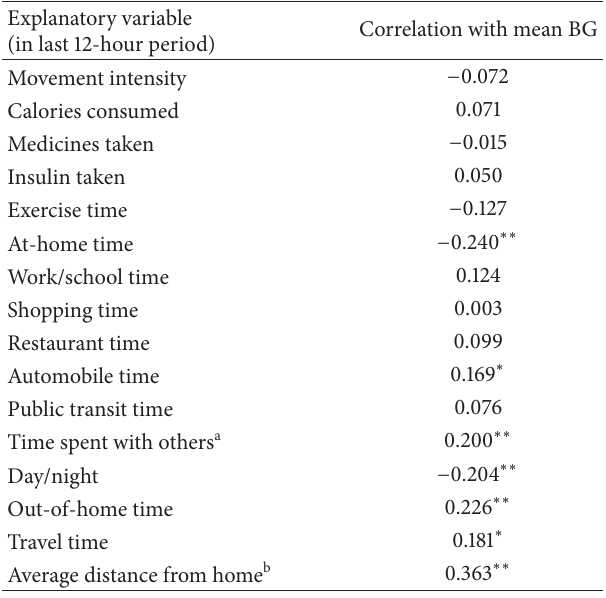
Table 4: ARIMA blood glucose modeling results, single participant ( 𝑛 = 864 , 𝑅 2 = 0.612